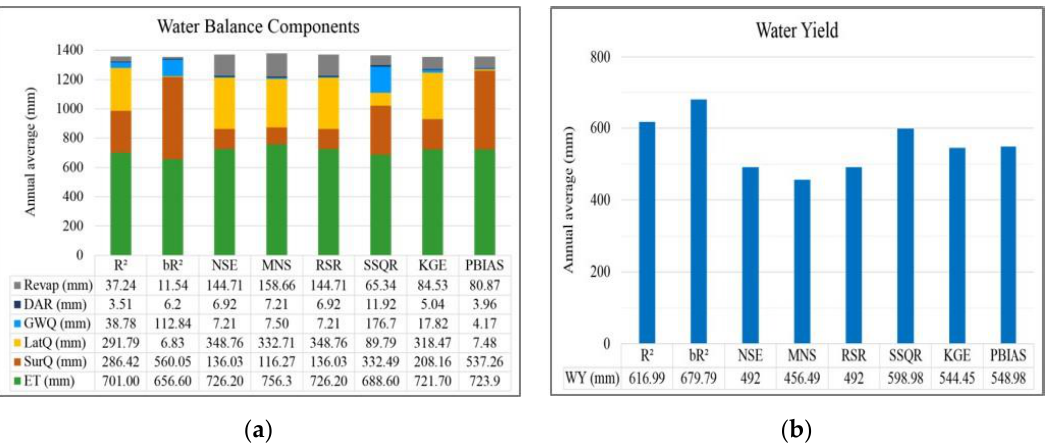
Figure 5. ( a ) Results of the water balance components and ( b ) water yields of different objective functions using the best parameter sets from the calibration process.